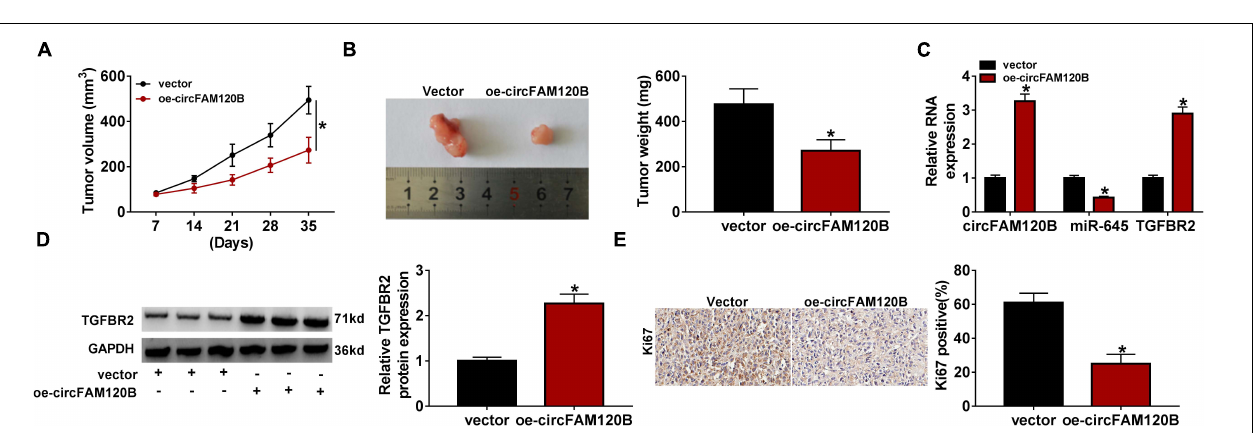
FIGURE 8 | CircFAM120B blocked tumor growth in vivo by regulating miR-645 and TGFBR2. (A) Tumor volume was measured once a week. (B) After 35 days, tumor tissues were removed for weighting. (C) The expression of circFAM120B, miR-645, and TGFBR2 mRNA in removed tumor tissues was detected by qRT-PCR. (D) The expression of TGFBR2 at the protein level was detected by western blot. (E) The enrichment of Ki67 in tumor tissues was detected by immunohistochemical (IHC) staining analysis. * P < 0.05.